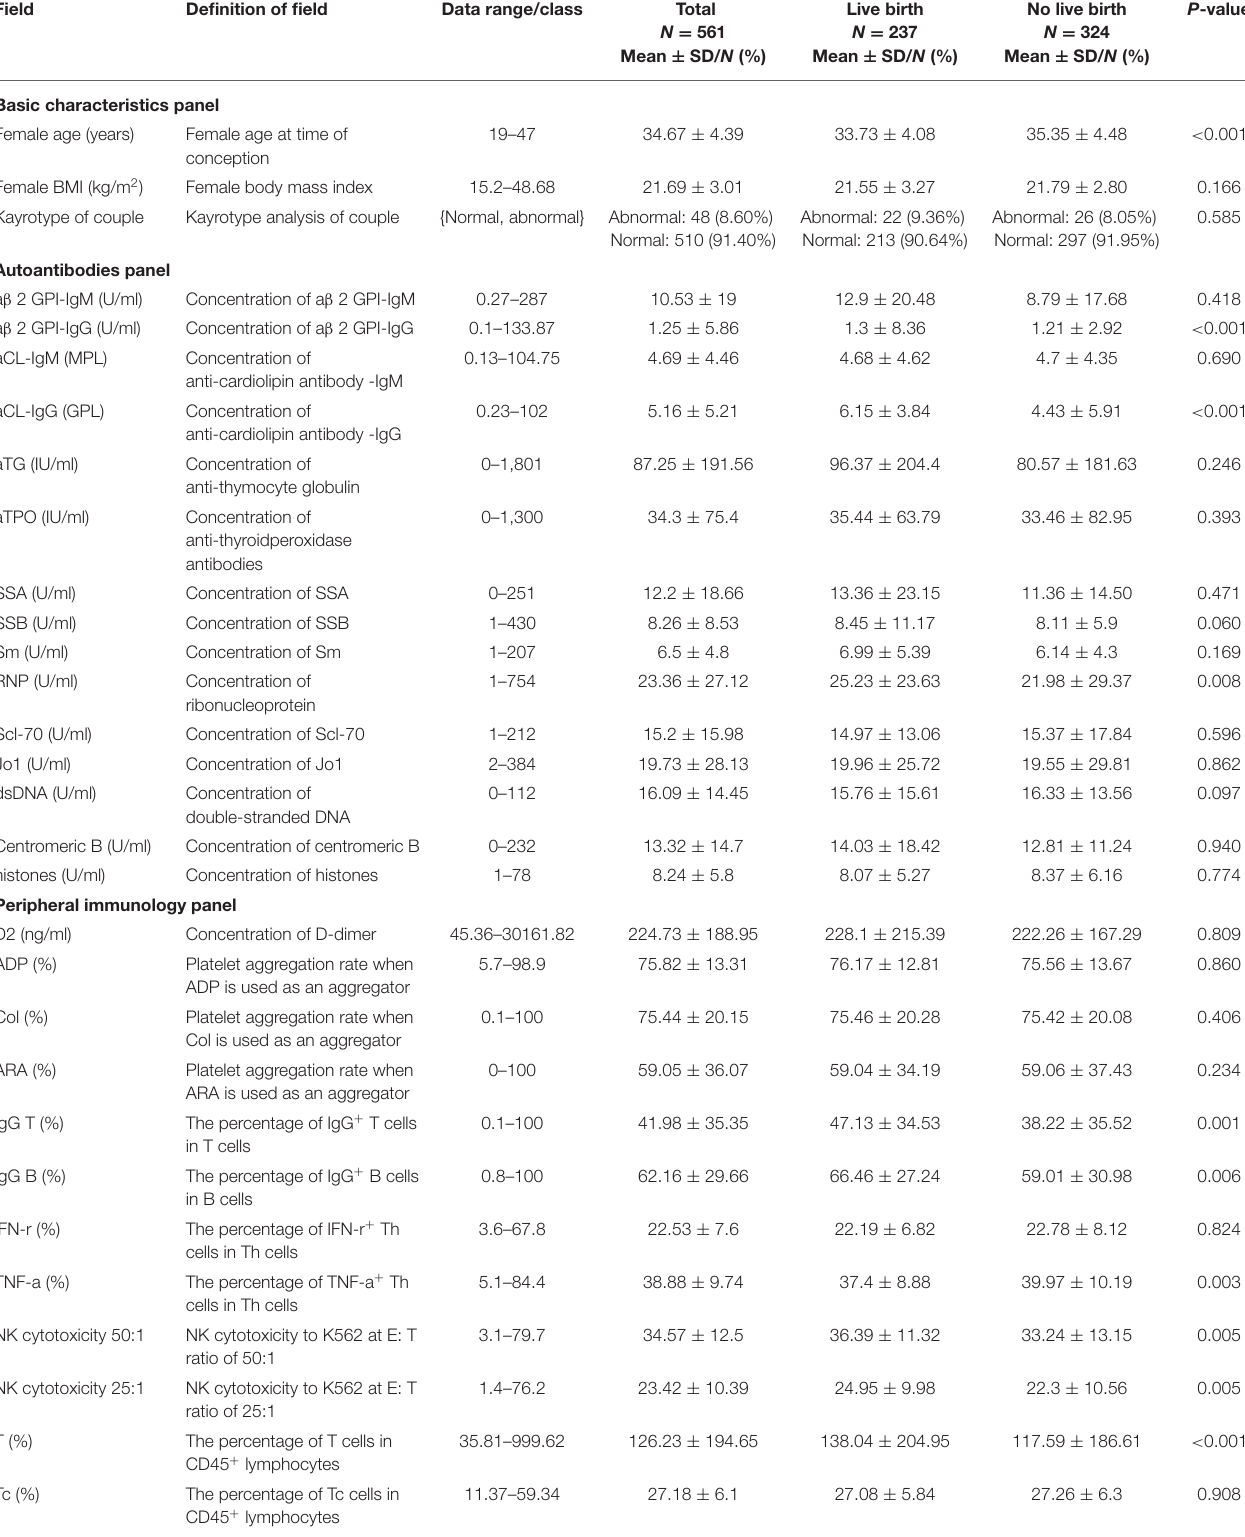
TABLE 2 | Definition and data range of variables in the